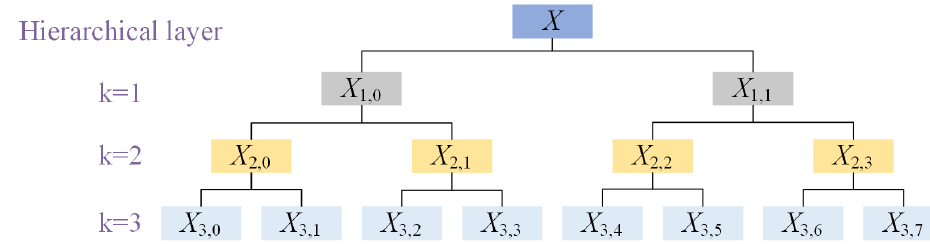
Figure 2. The hierarchical decomposition when k = 3.